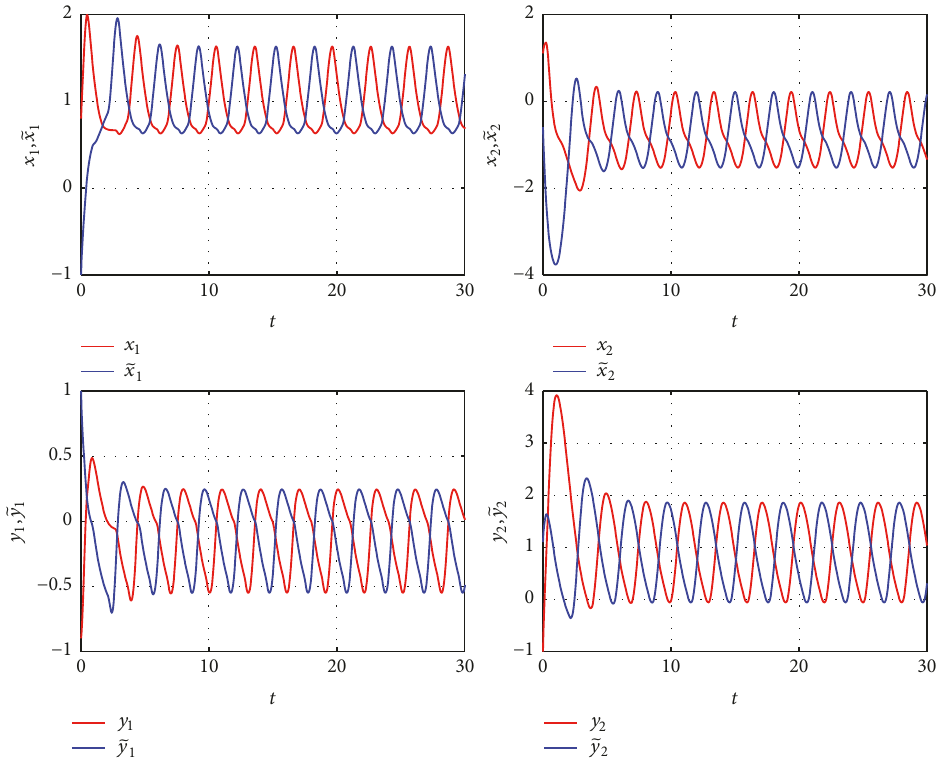
Figure 6: Time responses of real and imaginary parts of the variables 𝑧 1 , 𝑧 2 , ̃𝑧 1 , and ̃𝑧 2 without controller for example 2.